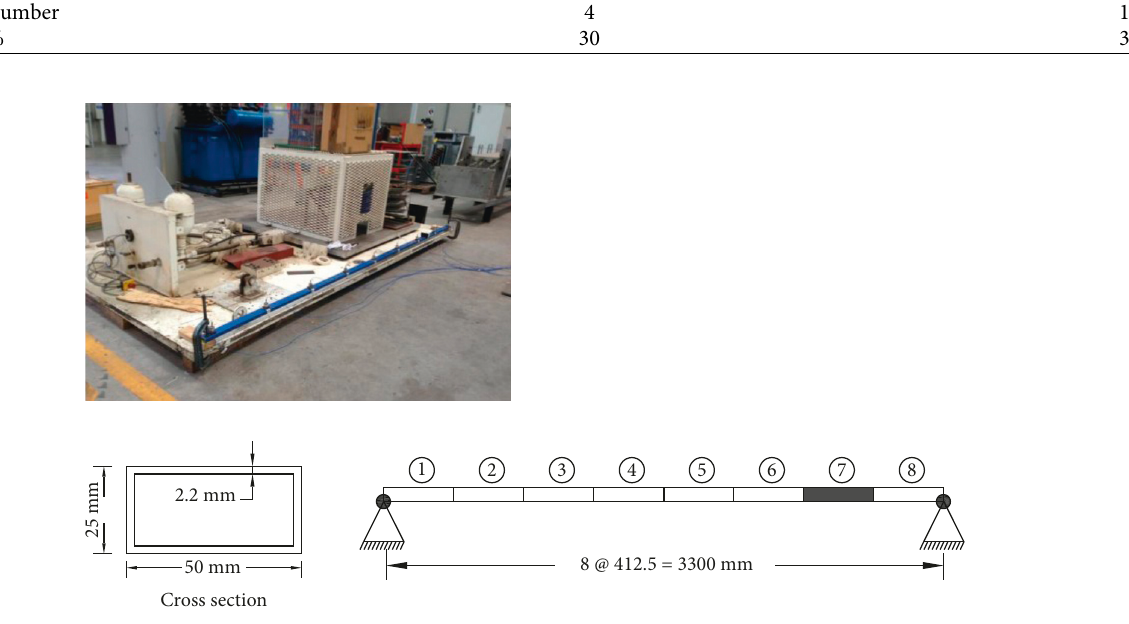
Figure 12: 8-element simply supported beam, experimentally tested by Ref. [51]. Table 8: Damage detection results of step 2 for the cantilever beam using EO and PSO.